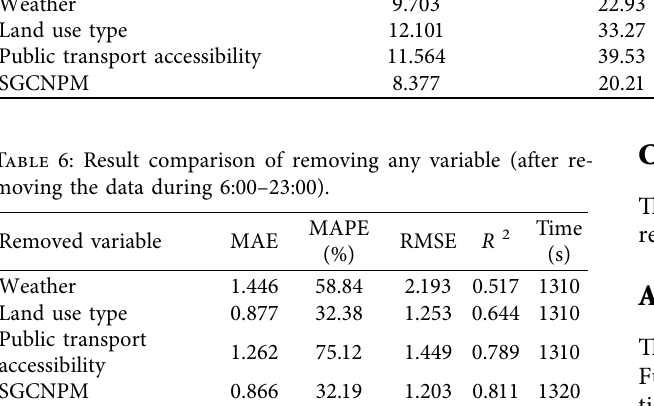
Table 5: Result comparison of removing any variable (after removing the data during 23:00–6:00). Removed variable